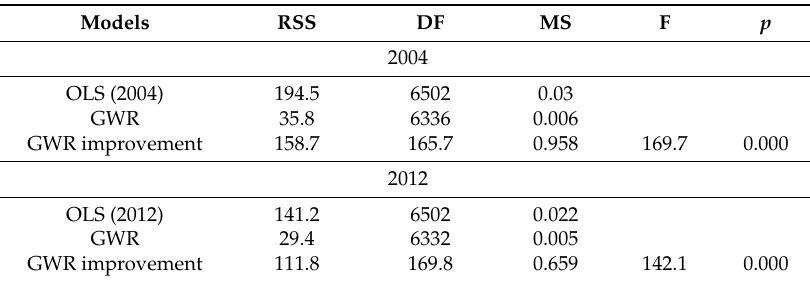
Table 4. ANOVA comparisons between GWR and global regression